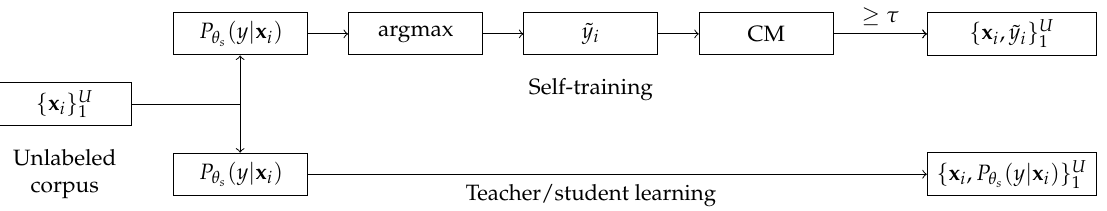
Figure 2. The pseudo label generation process of self-training and teacher/student